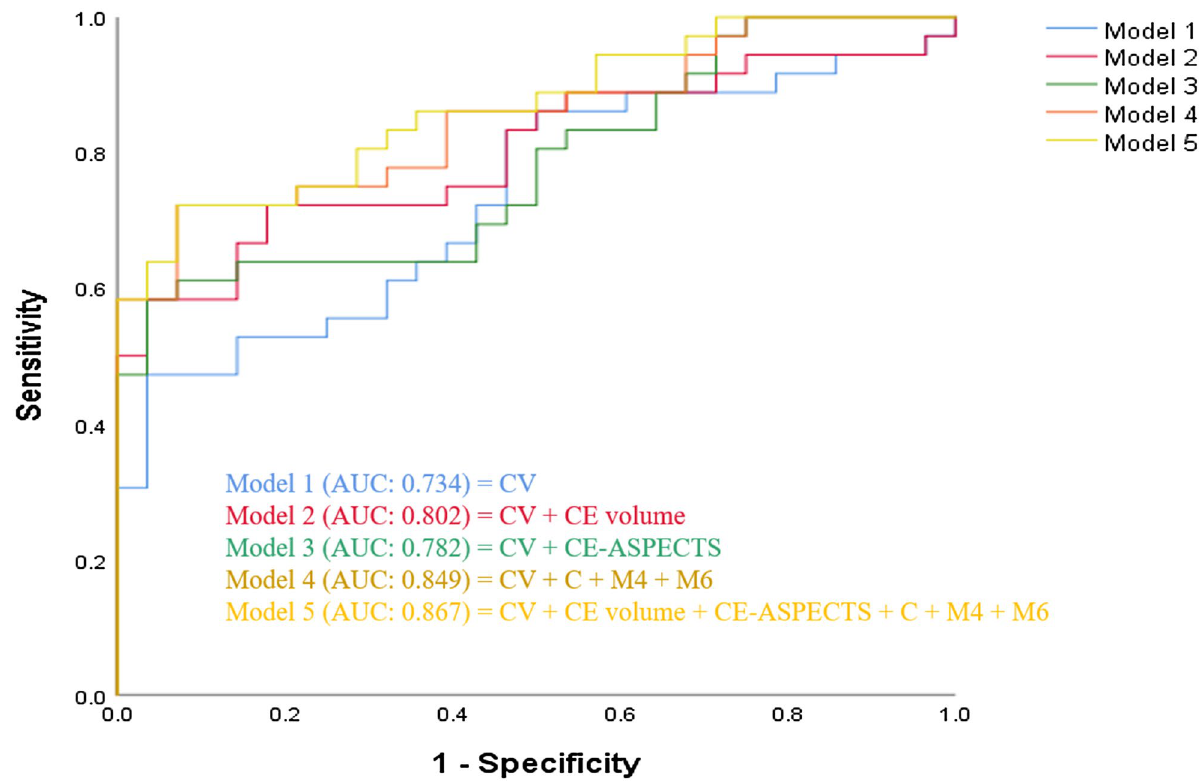
Figure 3. ROC curves comparing the potential of different models to predict poor outcome. CV, conventional variables including age, initial NIHSS, the procedure time, passes of retriever, recanalization status (mTICI 2b-3) and baseline